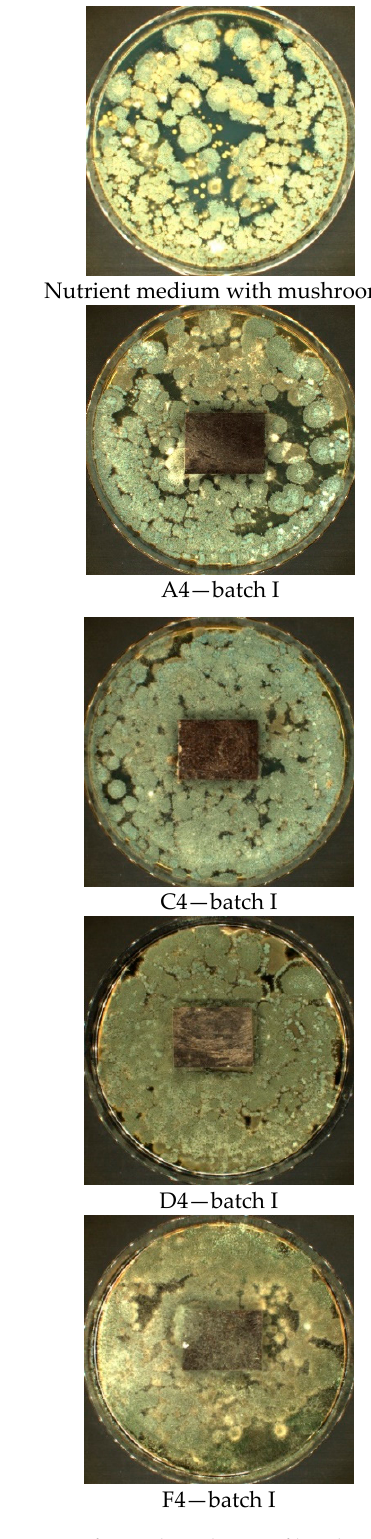
Figure 4. Method B—results of visual assessment of samples; photos of batch samples: I.